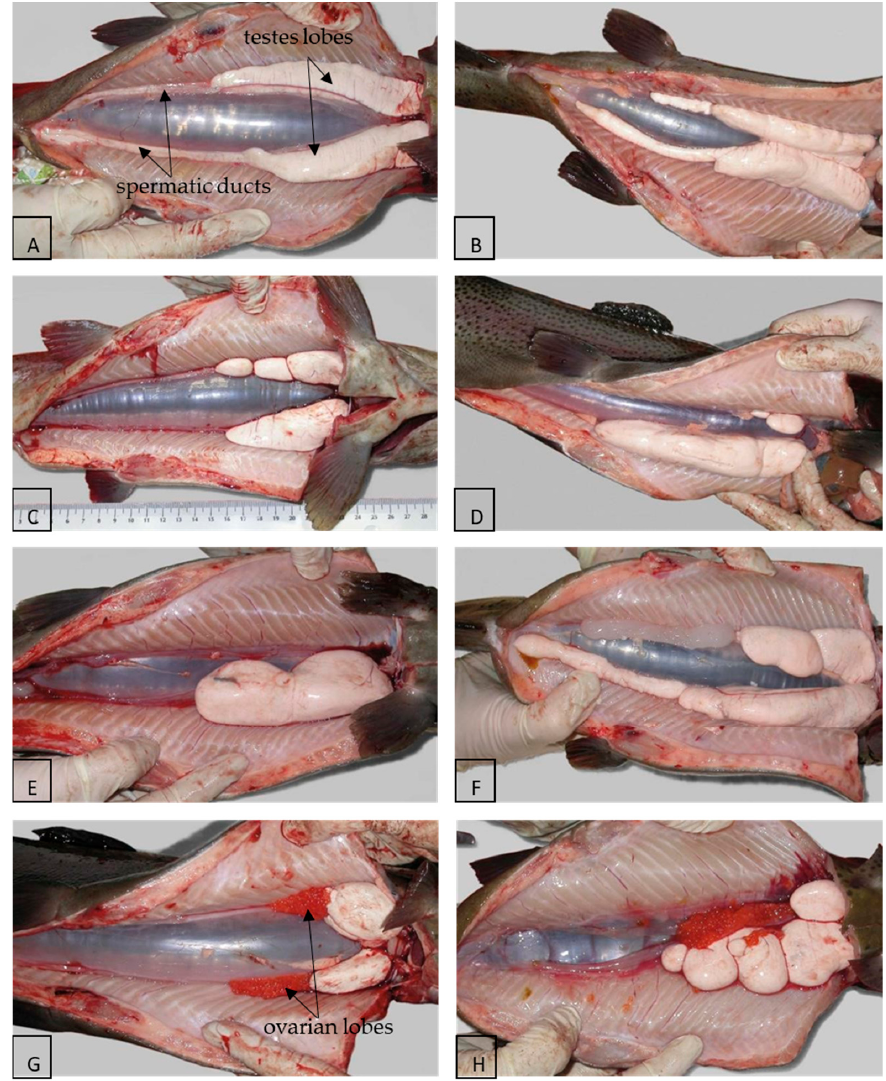
Figure 2. Types of macroscopic and morphological gonadal structures of rainbow trout sex-reversed females: ( A ) twin normal and similar sized testes lobes and functional permeable spermatic ducts; ( B ) twin normal and similar sized testes lobes and dysfunctional occluded spermatic ducts; ( C ) segregation and deep narrowing of one testes lobe; ( D ) clear asymmetry of testes size; ( E ) abnormal single testes lobe without spermatic ducts; ( F ) abnormal asymmetric and constricted testes lobes without spermatic ducts; ( G ) lobular type with a similar sequence of testicular and ovarian lobes on both gonad strands; and ( H ) asymmetric and constricted testes lobes with ovarian tissue within one gonad